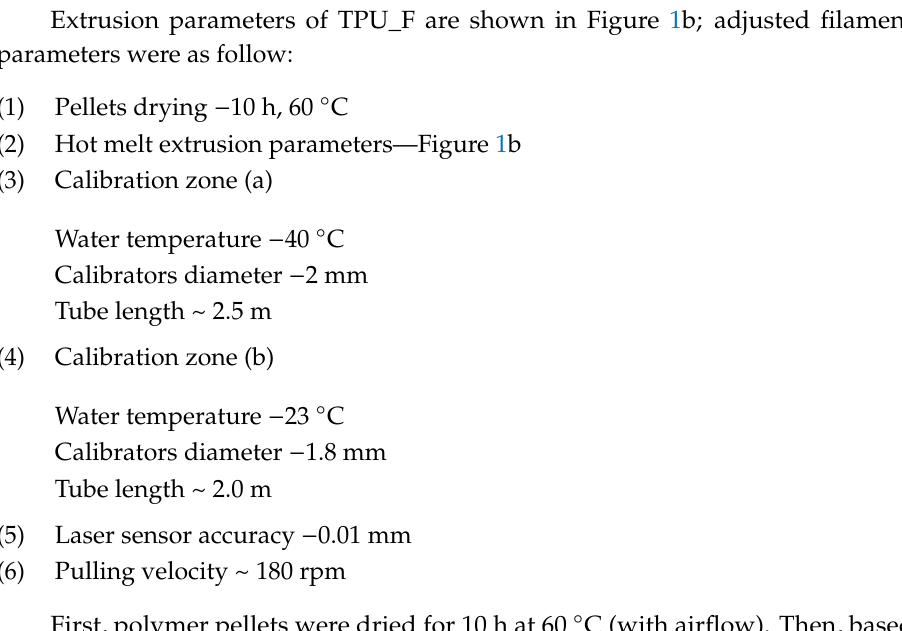
Figure 1. Scheme of thermoplastic polyurethane TPU filament (TPU_F) forming system ( a ), extrusion parameters of TPU_F formation ( b ).